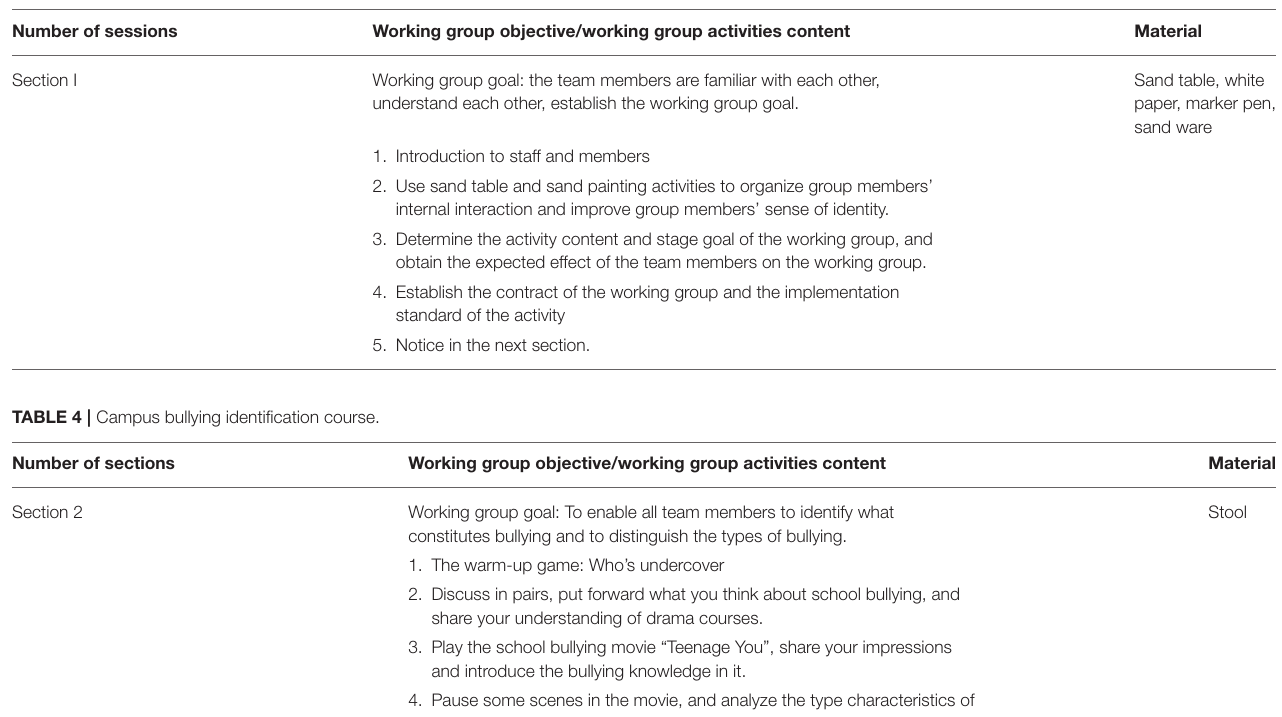
TABLE 3 | Working group activities and establishment of group relations.